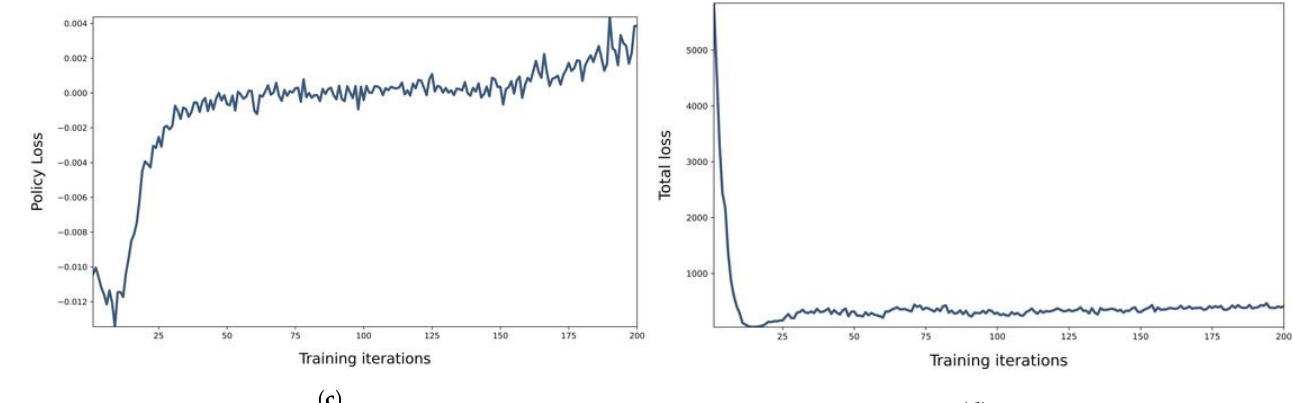
Figure 3. Results of Entropy, KL Divergence, Policy Loss and Total loss. ( a ) High to Low Entropy